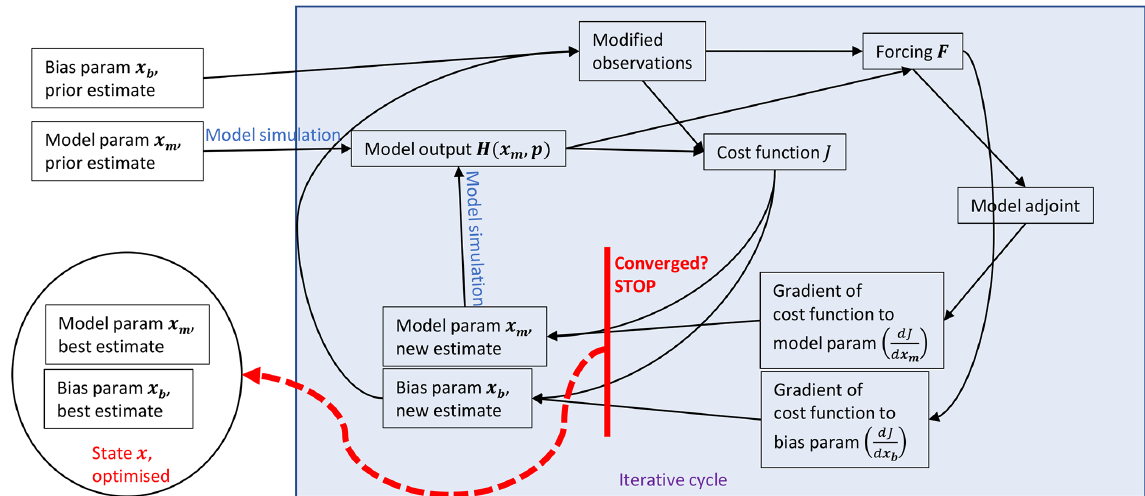
Figure 2. Slightly simplified sketch of the workflow of the inverse modelling framework when using the adjoint model for the derivatives with respect to model parameters. Note that, for the purposes of clarity, direct arrows between the parameters and the cost function and its gradients are not drawn. These arrows arise via the background part of the cost function (see the equations in the text). Everything within the shaded rectangle is part of the iterative cycle of optimisation. Model parameters that are not optimised are in the vector p . This vector is used together with x m in every model simulation. In case ICLASS is run in Monte Carlo mode (Sects. 3.6 and 4.2), this figure applies to the individual ensemble